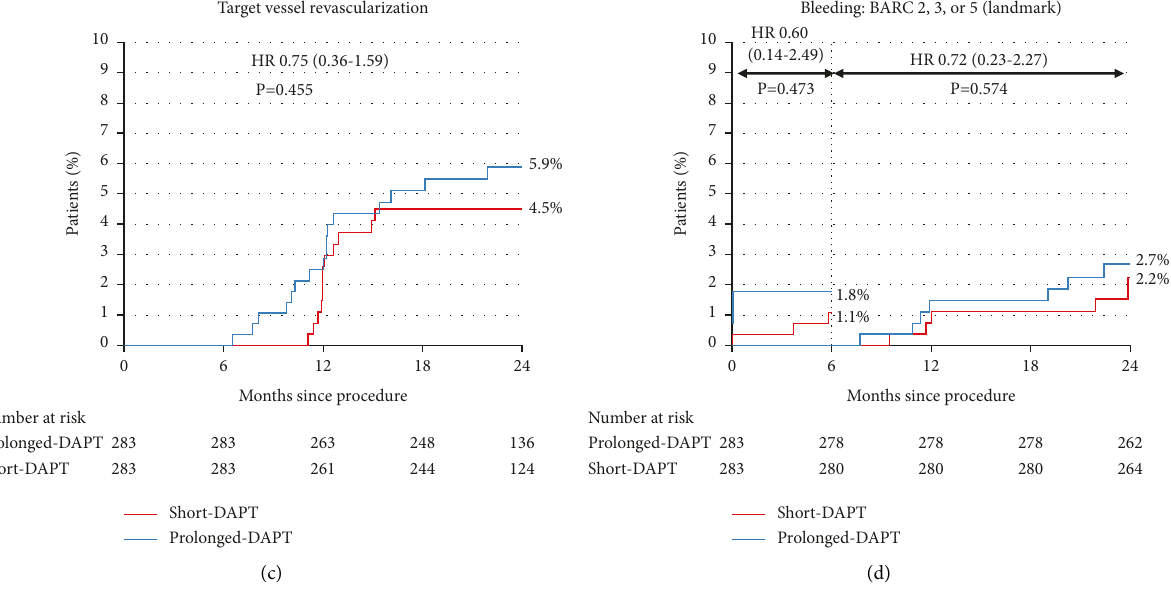
Figure 1: Kaplan-Meier survival curves for primary and secondary endpoints in the matched population. BARC, bleeding academic research consortium; DAPT, dual antiplatelet therapy; HR, hazard ratio; MI, myocardial infarction; TVR, target-vessel revascularization. (a) Death, MI, or TVR. (b) Cardiac death or MI. (c) Target vessel revascularization. (d) Bleeding: BARC 2, 3, or 5 (landmark).